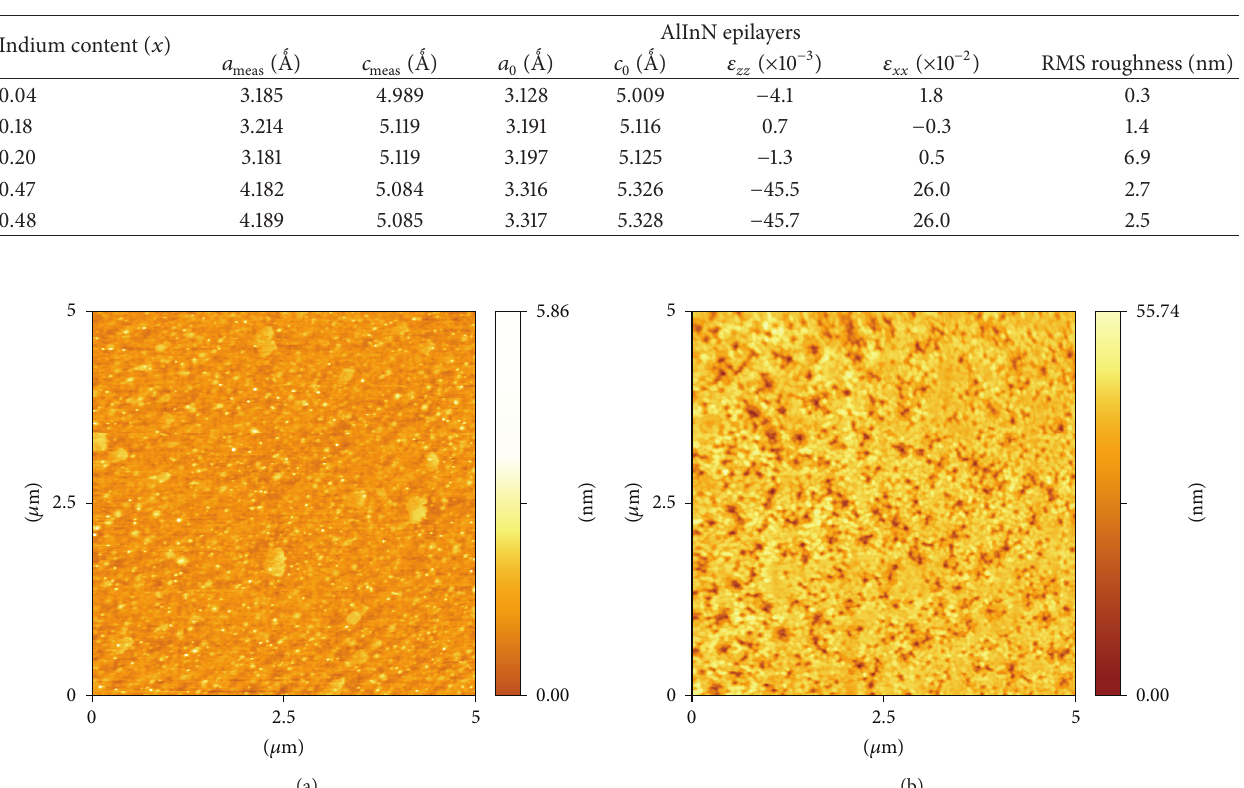
Table 1: The In content ( 𝑥 ), lattice parameters a and c and the strain components 𝜀 𝑧𝑧 and 𝜀 𝑥𝑥 of the AlInN epilayers, calculated from the meas meas RSM measurements and the relaxed lattice parameters 𝑐 0 and 𝑎 0 of the AlInN epilayers calculated by using Vegard’s law are given in column 4 and 5, respectively. In the last column, the RSM roughness of the 5 × 5 nm 2 scan AFM image is demostrated (the uncertainty in 𝑥 values is approx. Δ𝑥 = ±0.00277 ).